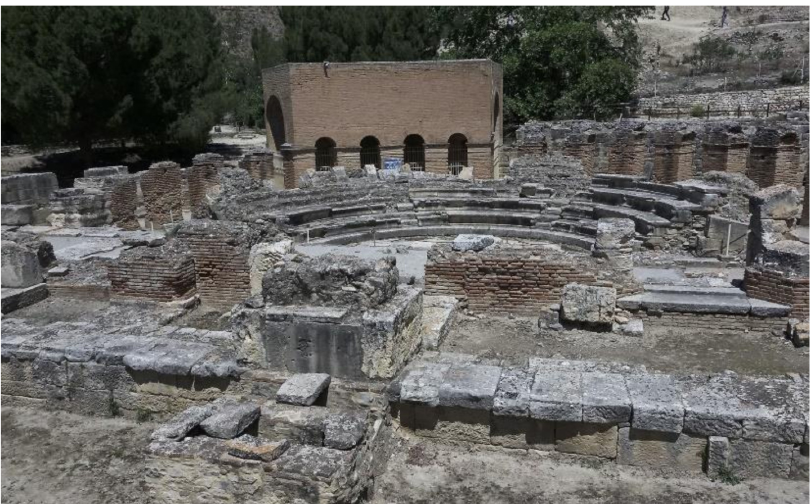
Figure 1. View of Gortys (Photo of A. N.